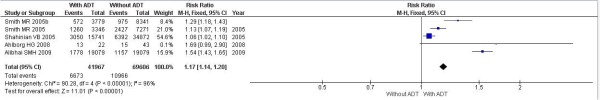
Adjusted risk ratio of fractures for patients under ADT as compared to patients not under ADT.